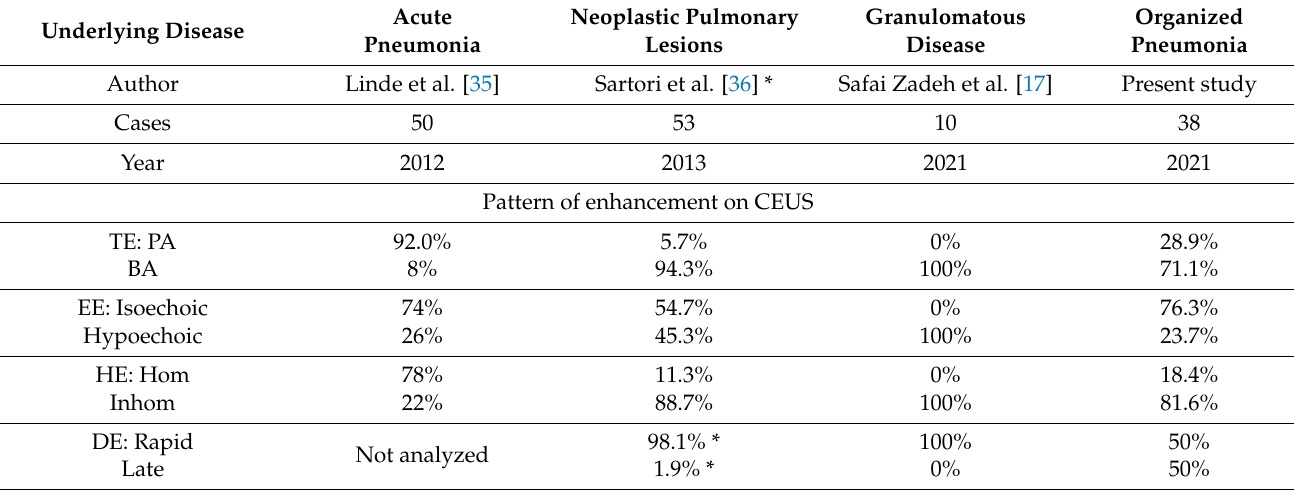
Table 2. Contrast-enhanced ultrasound perfusion patterns of pulmonary inflammatory and neoplastic lesions. Acute Underlying Disease